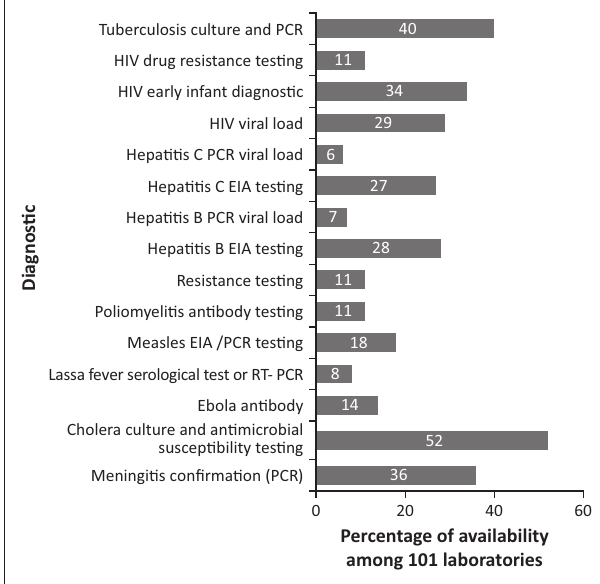
FIGURE 3: Gaps between actual diagnostic capacity and World Health Organization recommendations for minimal testing package in 101 level 4 and level 3 laboratories in 12 African countries (data from 2018 to